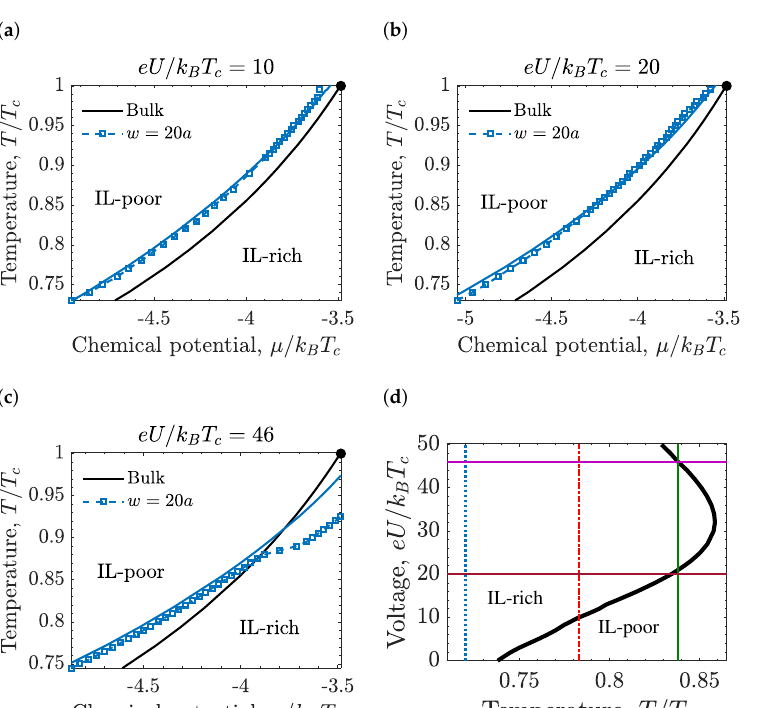
Figure 7. Capillary ionization of slit mesopores under applied voltages. ( a – c ) Phase diagram plotted in the temperature-chemical potential plane for ( a ) eU / k B T c = 10, ( b ) eU / k B T c = 20, ( c ) eU / k B T c = 46. The symbols have been obtained by numerical calculations, and the solid blue line corresponds to the results of the Kelvin equation. The solid black line is the phase coexistence in bulk, and the black dot is the critical point. ( d ) Phase diagram plotted in the voltage-temperature plane for the chemical potential µ / k B T c = − 4.57. The thick black line denotes the first-order transitions between the IL-rich and IL-poor phases while the thin vertical lines indicate the temperatures: T / T c = 0.72 (blue), T / T c = 0.78 (red), T / T c = 0.838 (green), used in Figure 9. The horizontal lines mark the values of voltage used in Figure 10. The slit width w = 20 a , where a is the ion diameter, and the ionophilicity a 3 h s / ξ 0 = 0.25, where ξ 0 is the bare correlation